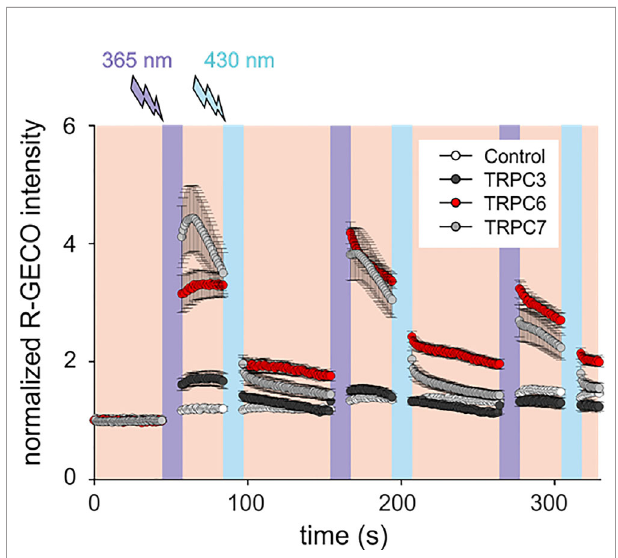
FIGURE 1 | OptoBI-1 photocycling induced Ca 2+ signaling triggered by overexpressed TRPC3, TRPC6 or TRPC7 channels in RBL-2H3 cells. Comparison of responses in cells overexpressing YFP-TRPC3, YFP-TRPC6 or TRPC7-CFP together with R-GECO as a Ca 2+ reporter. Cells expressing R-GECO was only used as a control. Time courses (mean ± SEM) of R- GECO fl uorescence intensity (red, 577 nm) during photoactivation of TRPC3 (black, n = 8 cells), TRPC6 (red, n = 23 cells), TRPC7 (gray, n = 21 cells), and controls (white, n = 10 cells). Cis-trans OptoBI-1 photocycling was repeated three times, by illuminating cells with UV (365 nm, 10 s; violet) followed by blue light (430 nm, 10 s,